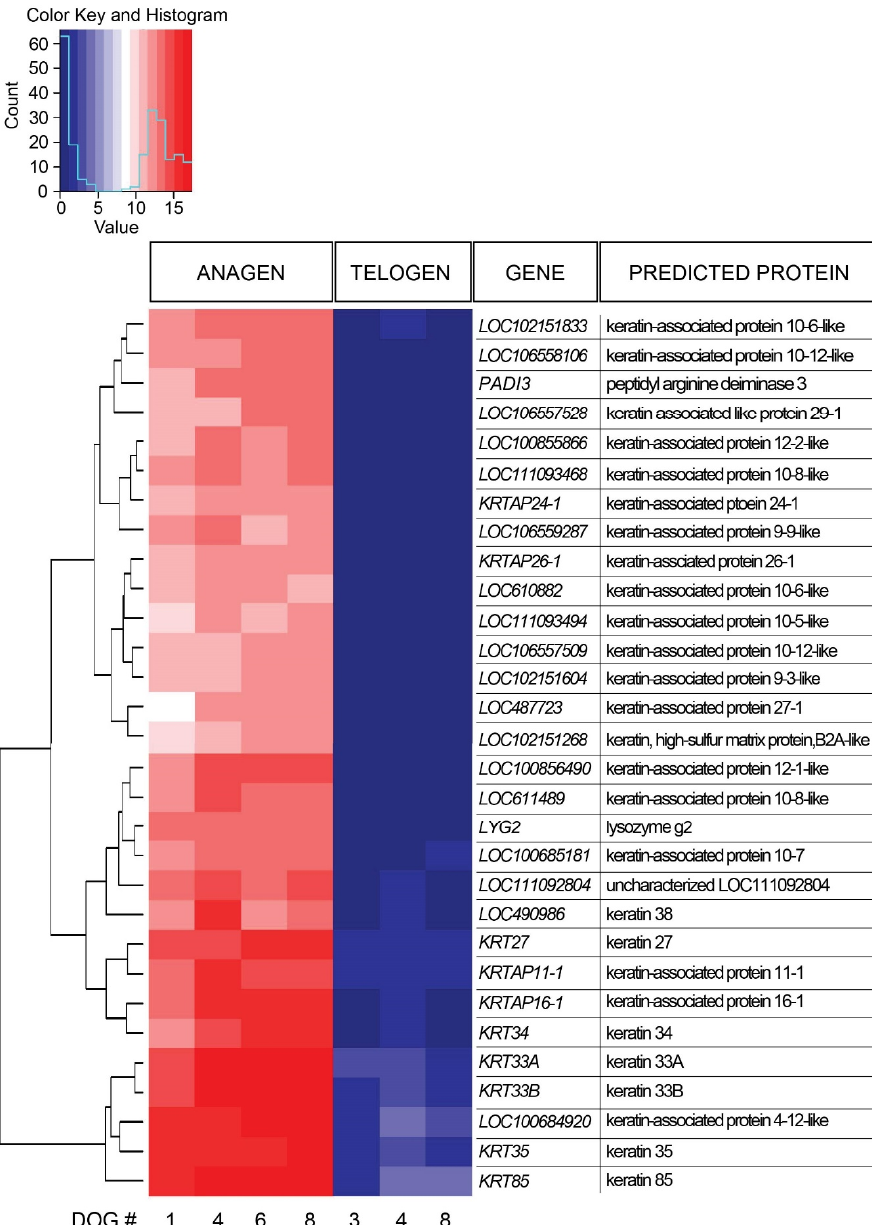
Figure 2. Heat map presenting hierarchical clustering of the 30 most significantly differentially expressed genes comparing late anagen and telogen hair cycle stages. High gene expression is shown in red, low expression in blue, intermediate DESeq2 normalized values in white and different shades of red and blue.